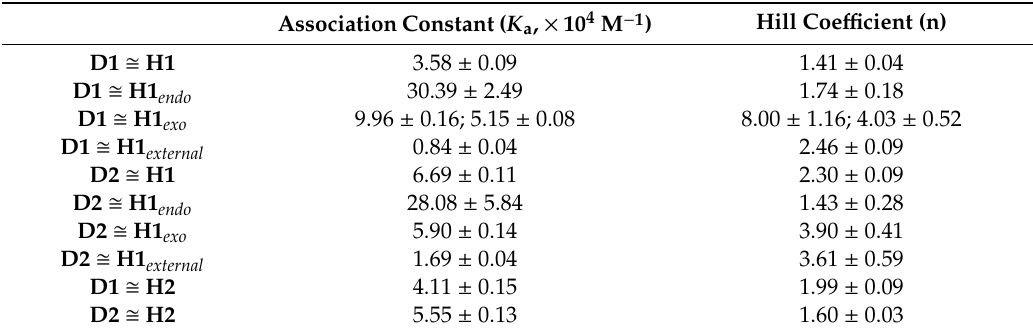
Figure 6. The nonlinear fits to Hill equation of UV-Vis titration experiments based on the absorption band centered at 360 nm for a ) D1 ≅ H2 and b ) D2 ≅ H2 . Table 1. Association constant and Hill coefficient determined by the nonlinear fit of the titration data to Hill equation.